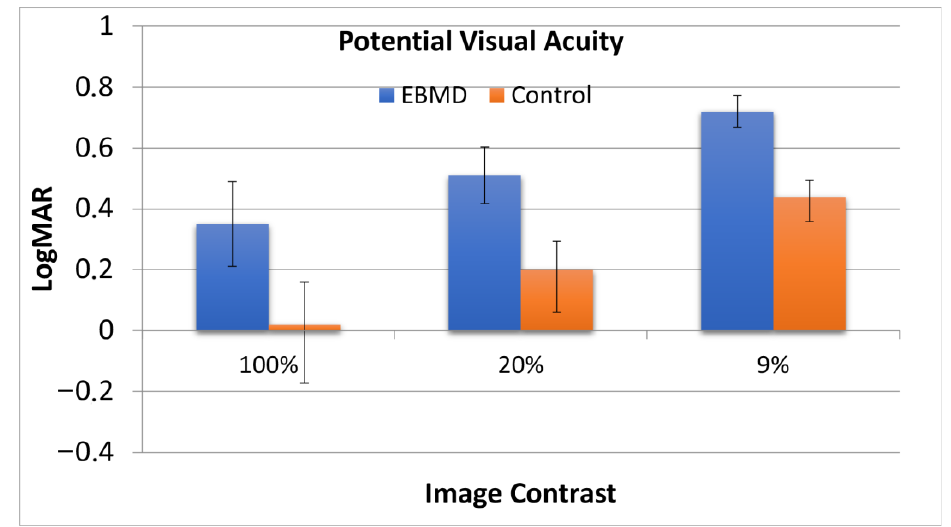
Figure 5. Potential visual acuity for EBMD patients and control group at 100%, 20%, and 9% image contrast, computed from the MTF function. All the differences between the groups were statistically significant with the highest difference recorded for 100% image contrast.